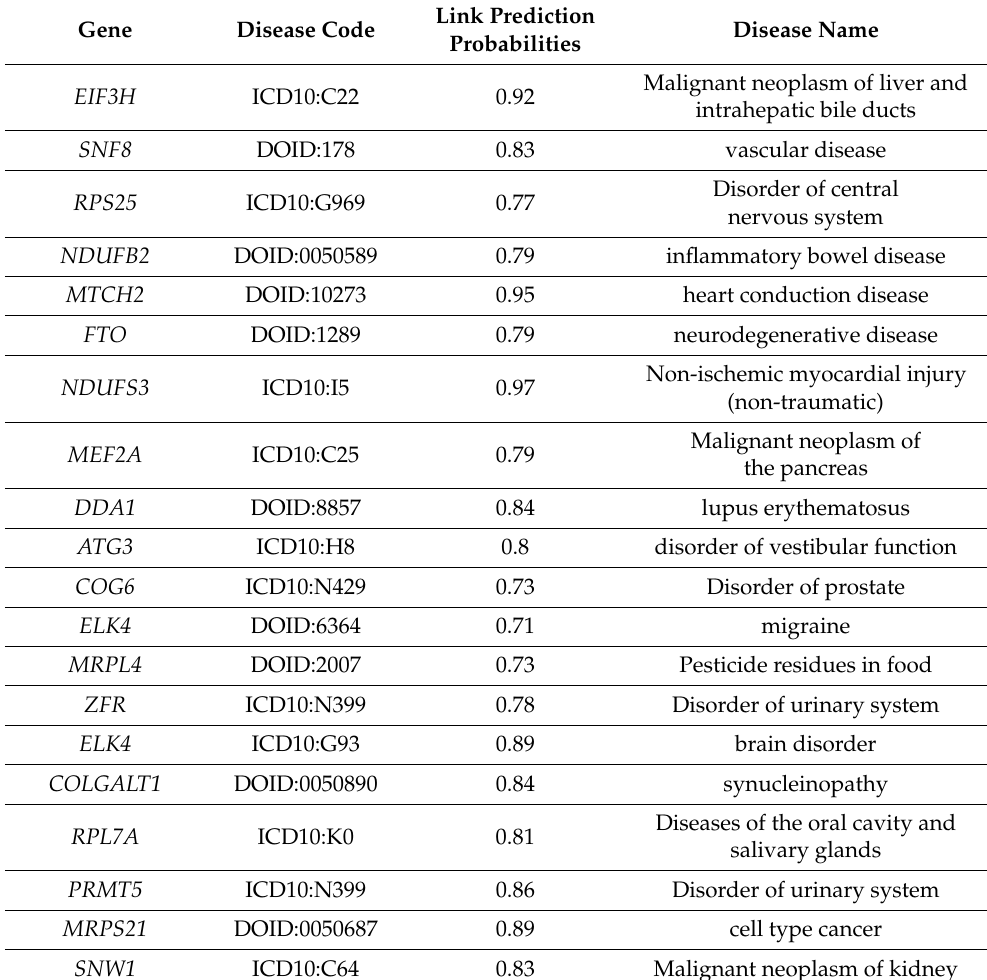
Table 1. Ranking of genes and diseases with new predicted links using GCN.